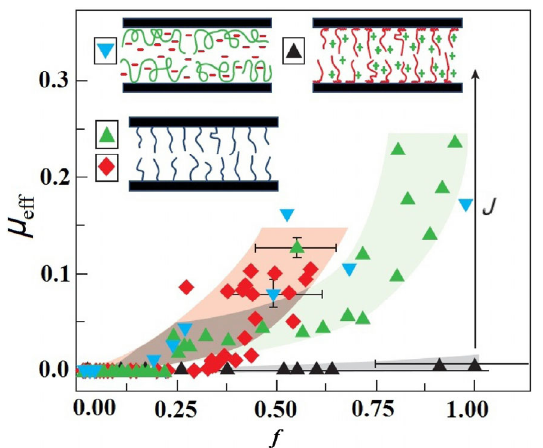
Fig. 9 Variation of the effective friction coef fi cient µ with volume fraction f of con fi ned polymer for different polymer lubricants. Reproduced with permission from Ref. [31]. Copyright Managed by Nature Publishing Group,